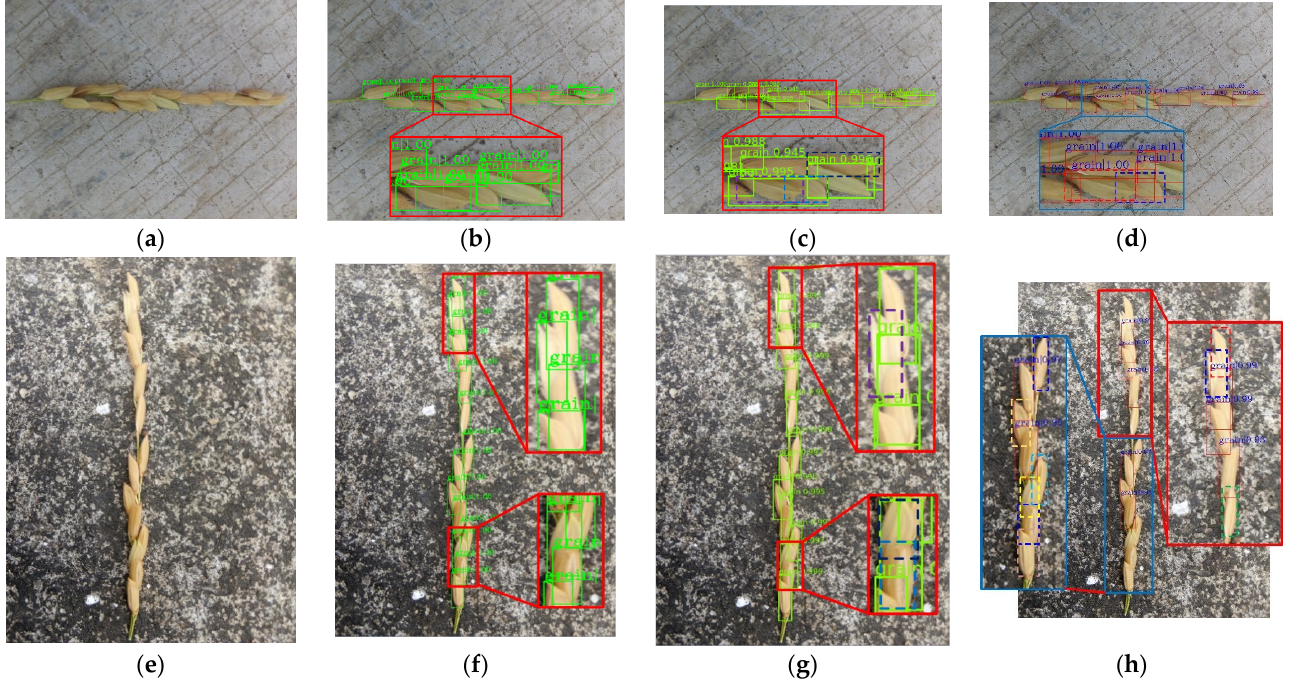
Figure 6. Three examples that show the grain detection results using the grain detection model, the original Faster R ‐ CNN model and SSD model with a cutoff confidence value of 0.9; the texts indicate the confidence scores; ( a , e ): original image; ( b , f ): detection results of grain detection model; ( c , g ) detection results of the Faster R ‐ CNN model; ( d , h ) detection results of the SSD model.